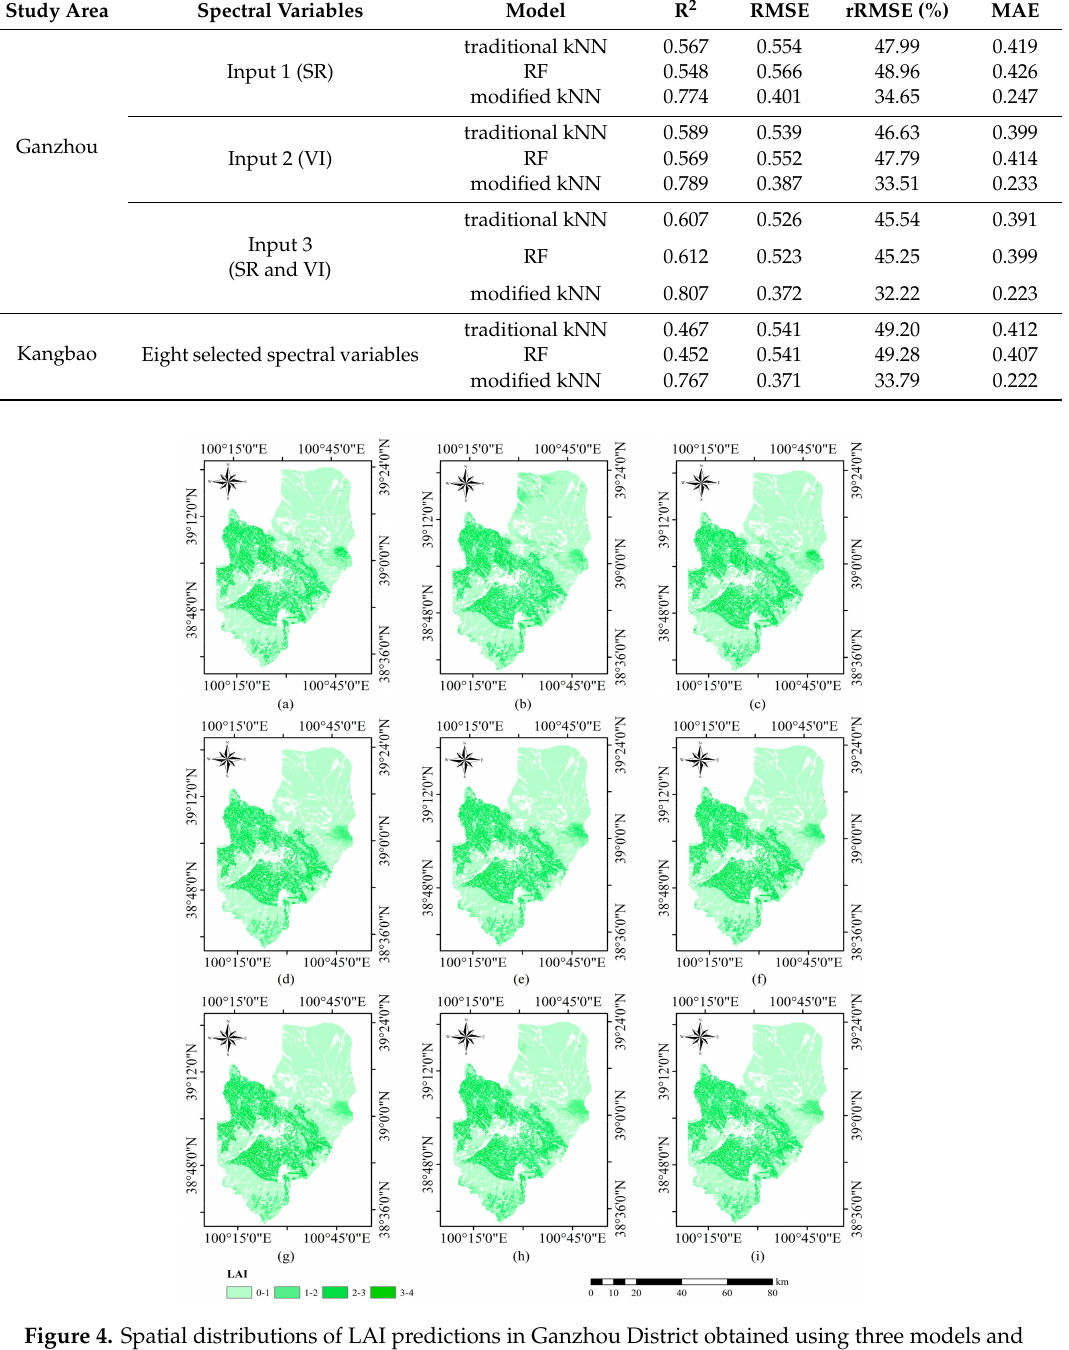
Figure 4. Spatial distributions of LAI predictions in Ganzhou District obtained using three models and three set inputs of the selected spectral variables: ( a ) Input 1 and traditional kNN; ( b ) input 1 and RF; ( c ) input 1 and the modified kNN; ( d ) input 2 and traditional kNN; ( e ) input 2 and RF; ( f ) input 2 and modified kNN; ( g ) input 3 and traditional kNN; ( h ) input 3 and RF; and ( i ) input 3 and modified